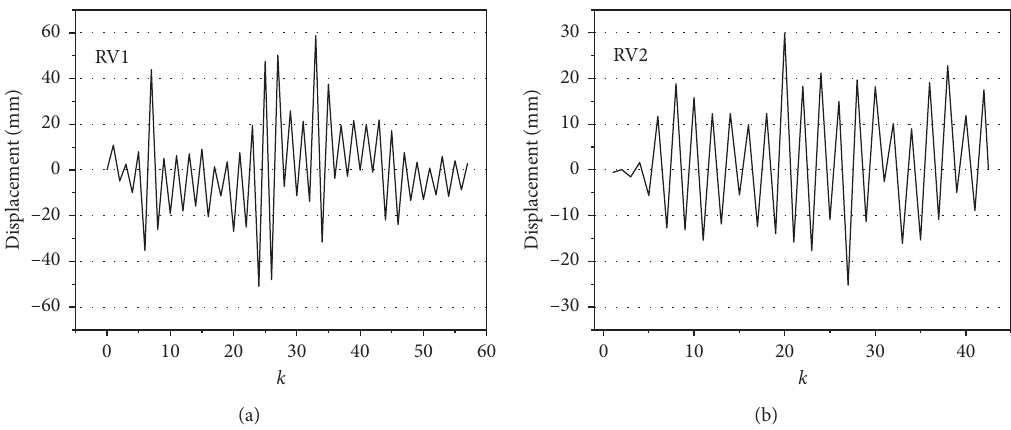
Figure 3: The RV displacement patterns imposed on the test specimens [17]: (a) RV1. (b) RV2.